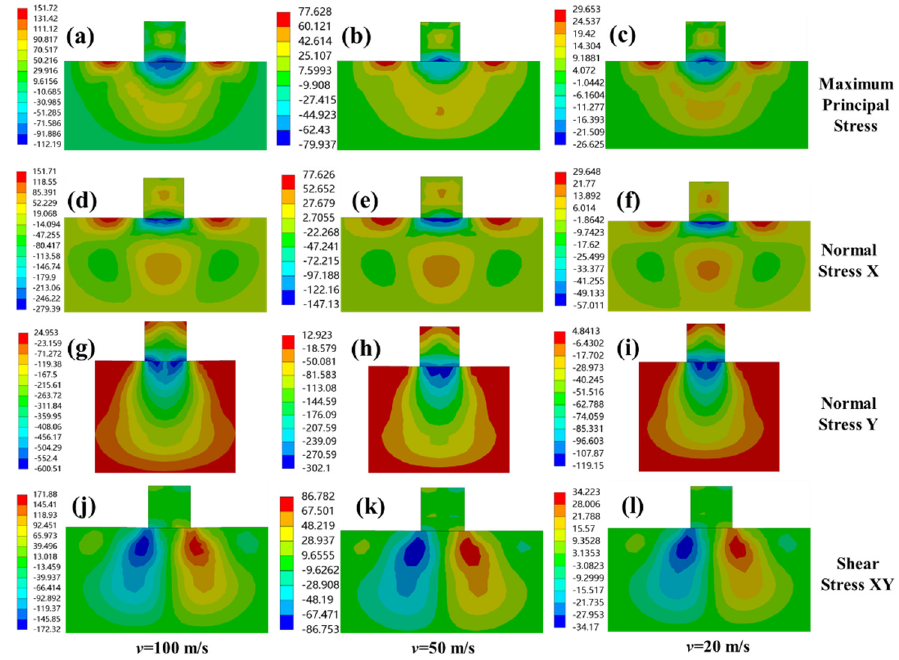
Figure 10. The contour plots of ( a – c ) maximum principal stress, ( d – f ) normal stress X, ( g – i ) normal stress Y and ( j – l ) shear stress XY for different erosion velocities at an erosion angle equal to 90°.